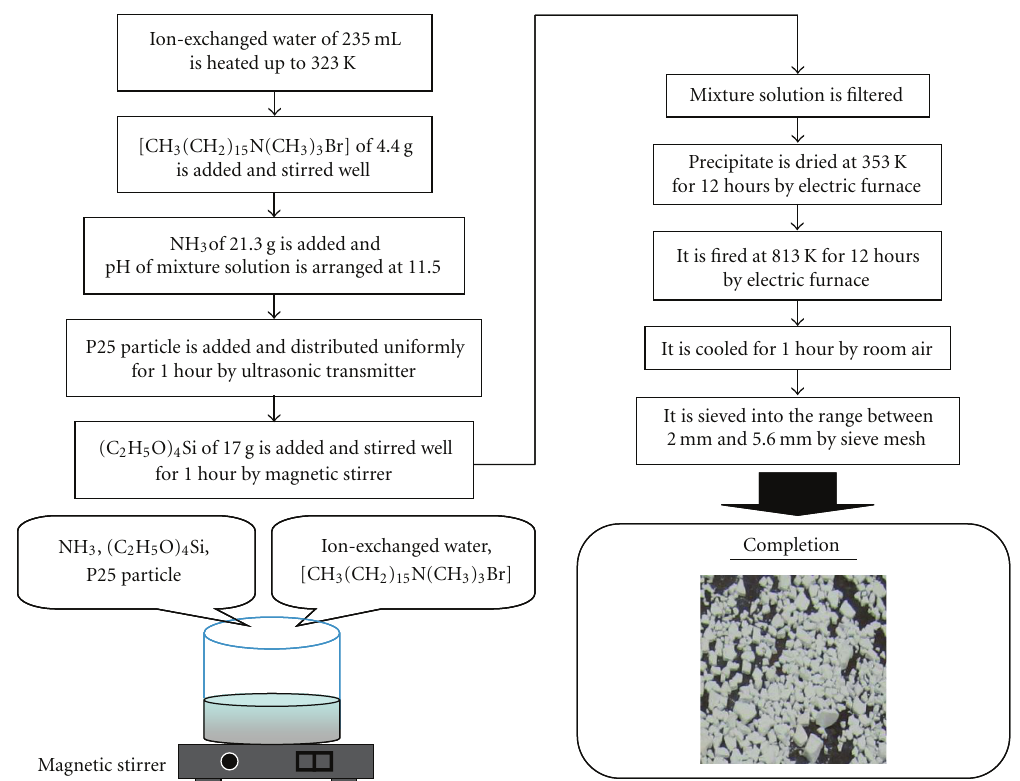
Figure 1: Preparation method of mesoporous silica loaded with TiO 2 .